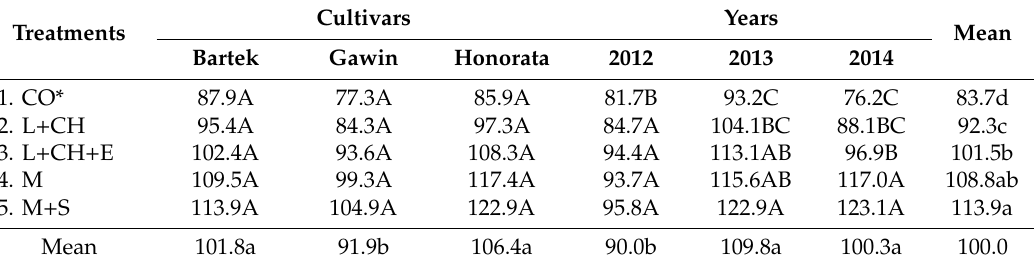
Table 10. Average weight of one potato tuber